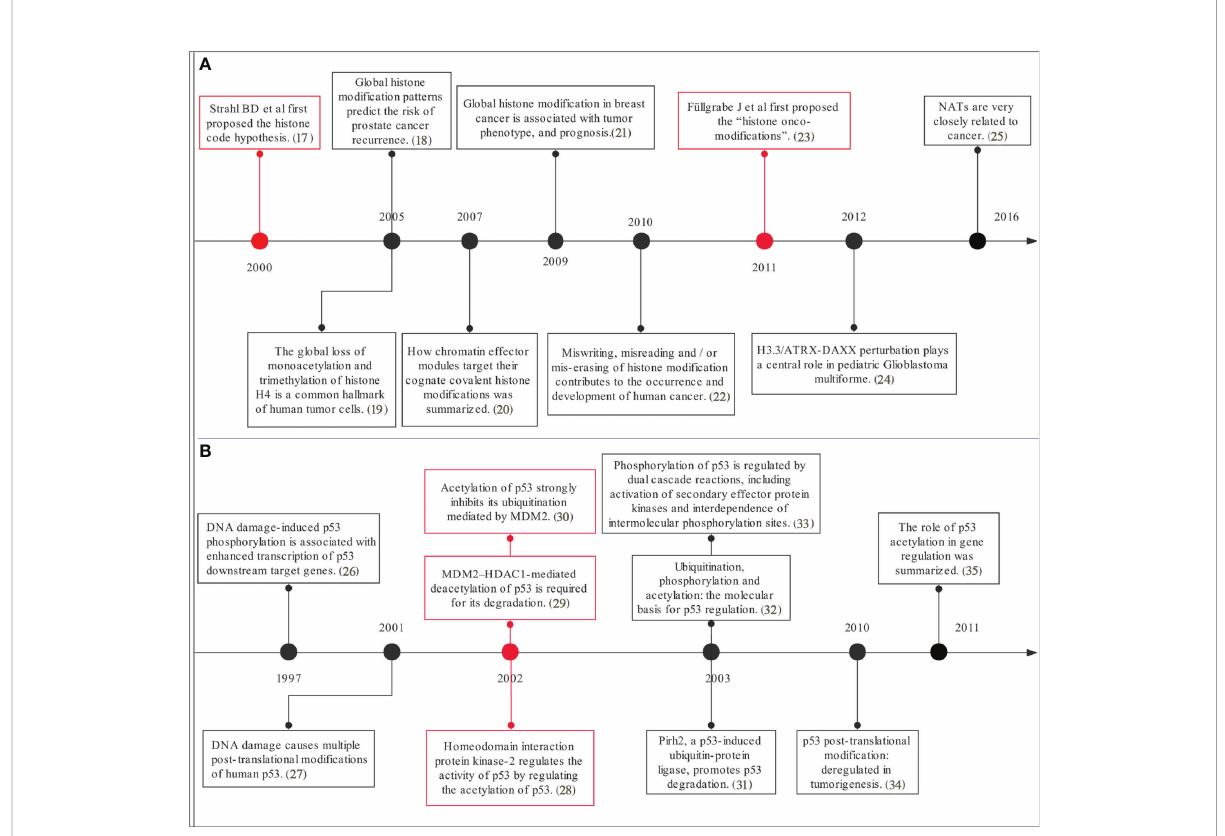
FIGURE 6 The timeline plot of the citation. Source: authors with ProcessOn (https://www.processon.com). The content in this fi gure corresponds to Figure 5 for (A) histone modi fi cation and tumor study and for (B) p53 modi fi cation and tumor